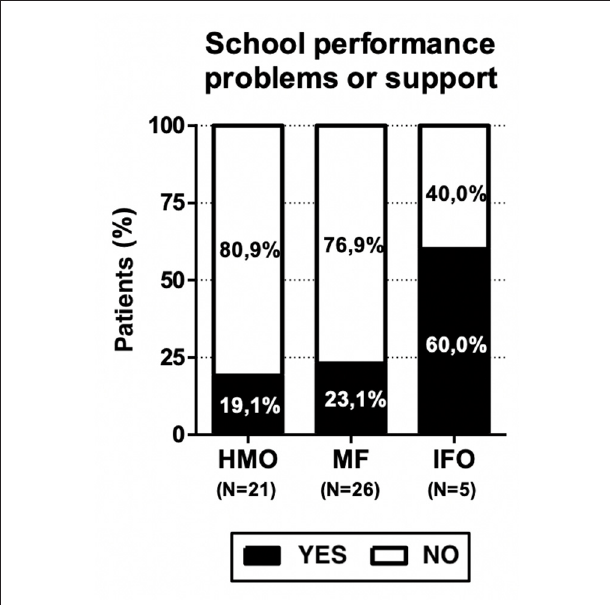
FIGURE 6 | Prevalence of school performance problems among the study population.